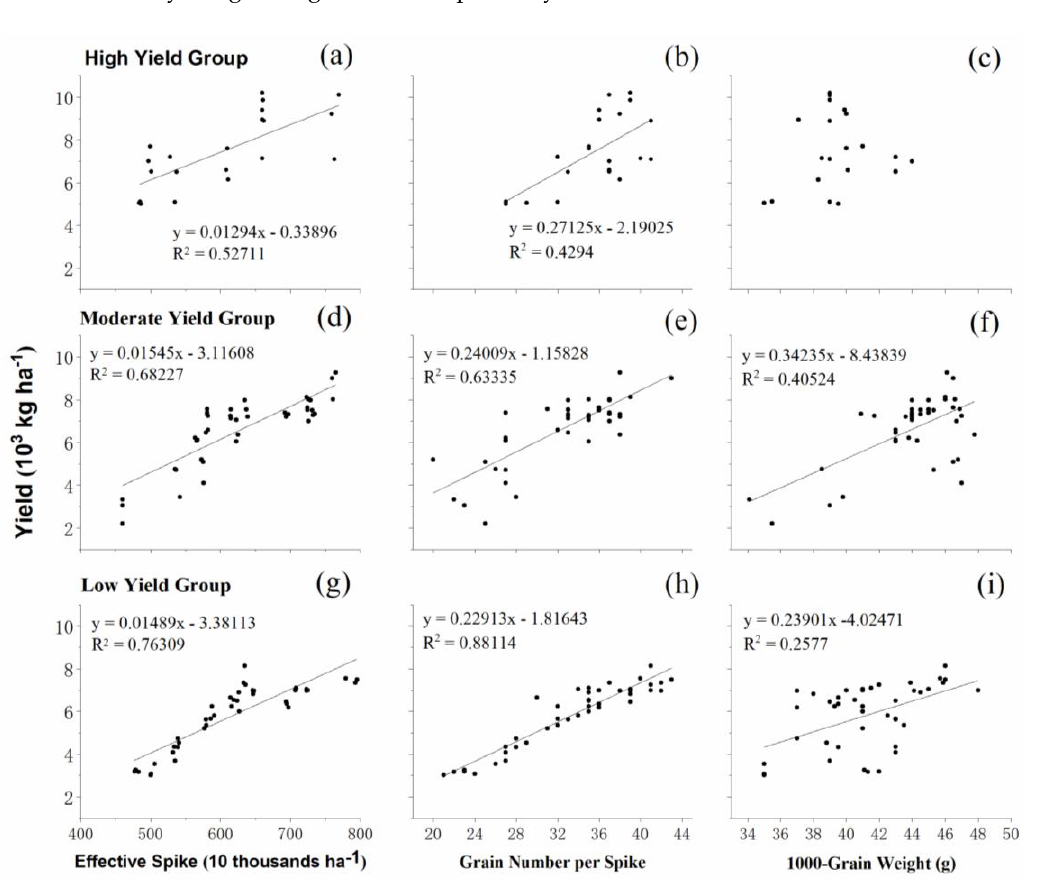
Figure 3. Regression correlations of yield (10 3 kg ha − 1 ) grain yield, effective spikes, 1000-seed weight at the high ( a , b , c ), moderate ( d , e , f ), and low ( g , h , i ) grain yield groups during the cropping years of 2013 to 2018 in China North Plain experiment sites.